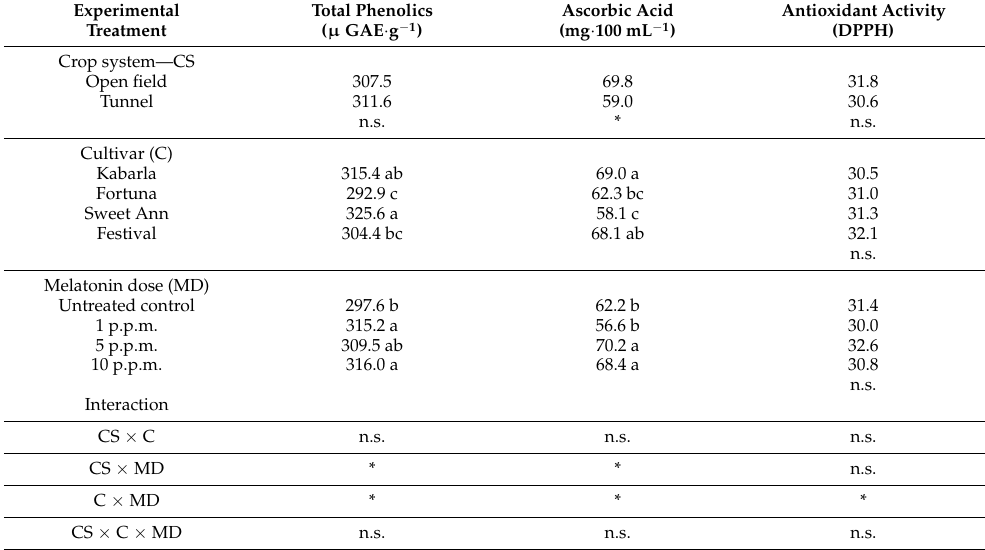
Table 3. Effects of crop system, cultivar and melatonin dose on antioxidant compounds and activity of strawberry fruits grown in Turkey.